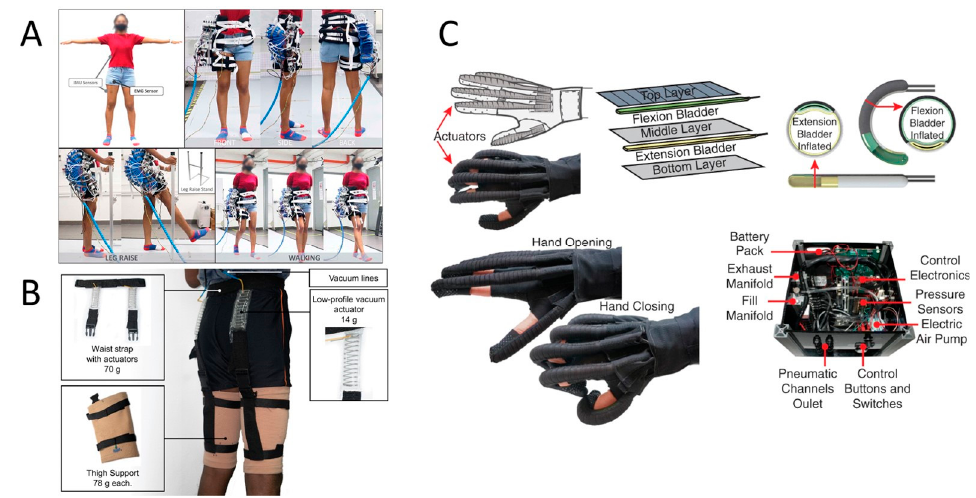
Figure 4. Illustrations of pneumatically driven soft wearables. ( A ) Jackson et al. [109] describe their work on a fabric based soft wearable that assists in hip flexion during walking. The system must be tethered to an external air source for operation. ( B ) Kulasekera et al. [113] describe their work on a vacuum ‐ based rehabilitative wearable that facilitates sit ‐ to ‐ stand transitions. The vacuum pump is located remotely and the wearable has to be tethered during operation. ( C ) Unlike the previous two examples, Cappello et al. [124] devise a portable control box that is equipped with an electric air pump for pressure generation. The hand rehabilitative exoskeleton assists with hand opening and closing.